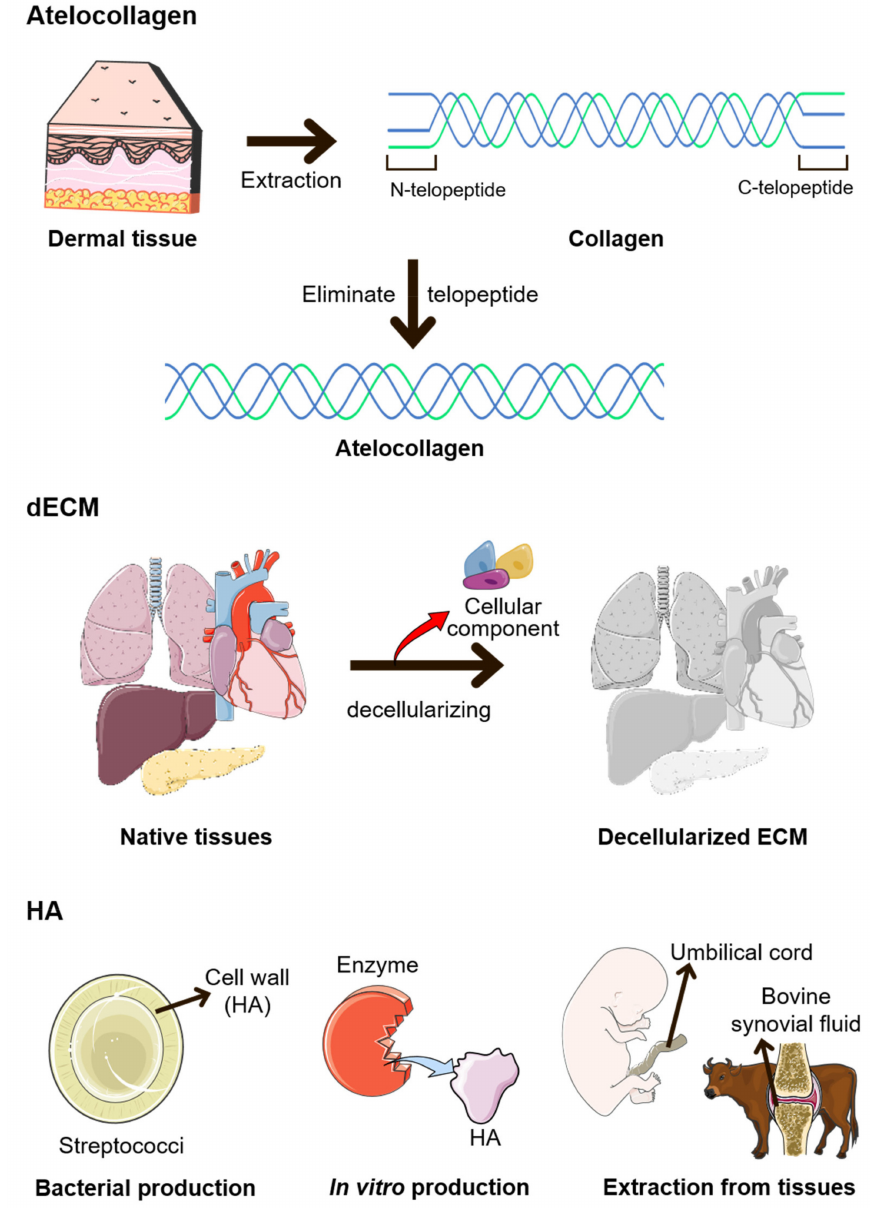
Figure 1. Methods for manufacturing modified ECMs. Atelocollagen is manufactured by removing telopeptides from collagen. Decellularized ECM (dECM) is manufactured by eliminating cellular components from native tissues. Finally, hyaluronic acid (HA) is produced using several methods. Bacteria such as Streptococci are representative bacterium that produce HA. Additionally, HA can be manufactured using enzymes, the umbilical cord, or bovine synovial fluid